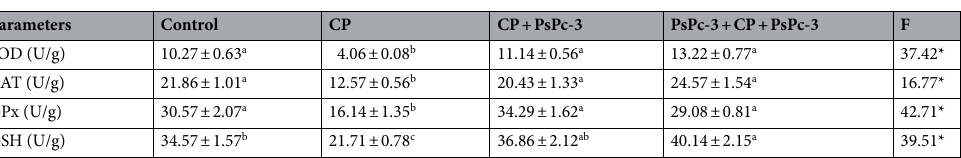
Table 1. Effect of PsPc-3 on SOD, SOD, GPx, and GSH. The data are means ± SE ( n = 8). One-way ANOVA followed by Tukey’s multiple comparison post hoc test; the differences were considered significant at P ≤ 0.05. Small letters (a, b, c) indicate a statistically significant difference. F (*) indicates a statistically significant difference.